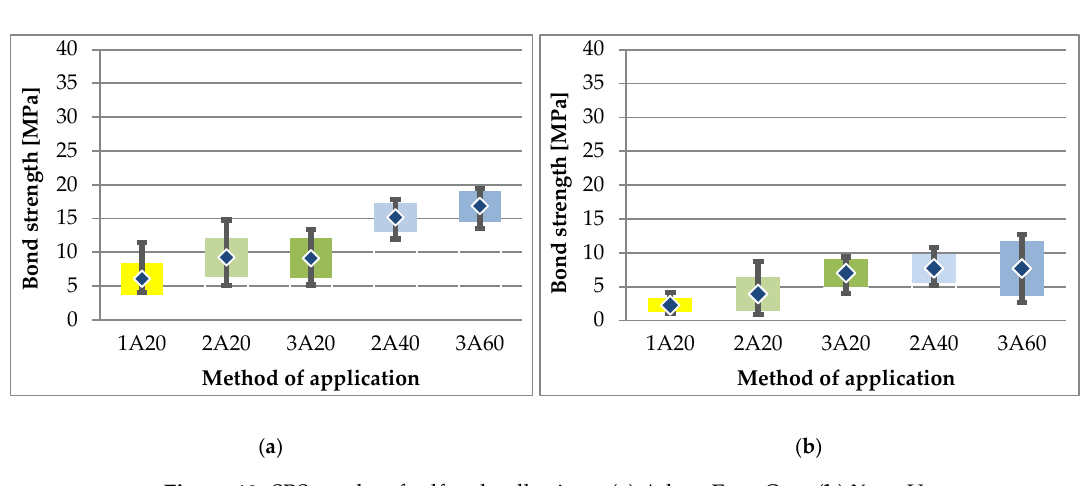
Figure 10. SBS results of self-etch adhesives: ( a ) Adper Easy One; ( b ) Xeno V.